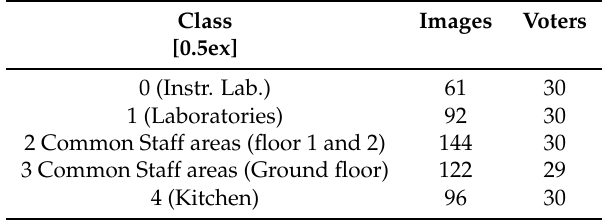
Table 3. Summary of the second data set and participants in the